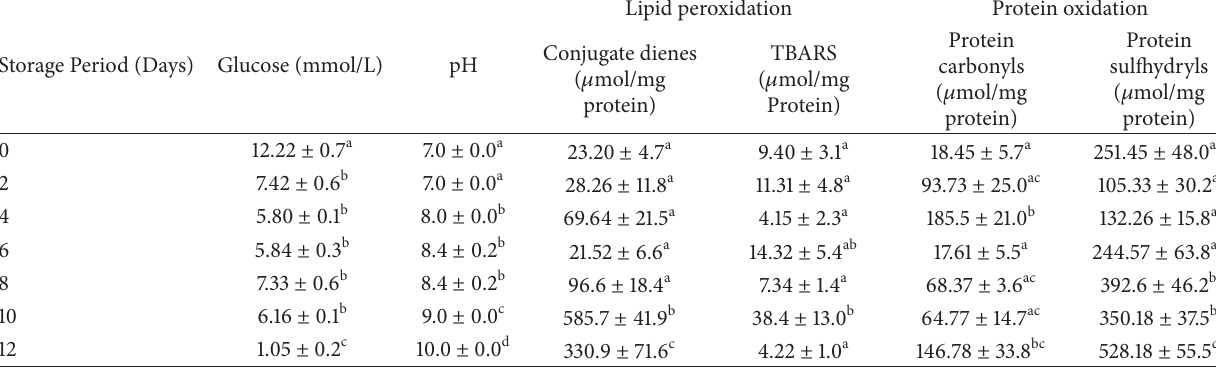
Values are expressed as mean ± SE of five animals/group. Changes between groups were analyzed by one-way ANOVA followed by Tukey-Kramer multiple comparison test, using GraphPad Prism 6 software. 𝑃 < 0.05 was considered significant. Changes between the groups are represented in lower case. Those not sharing the same letters are significantly different.